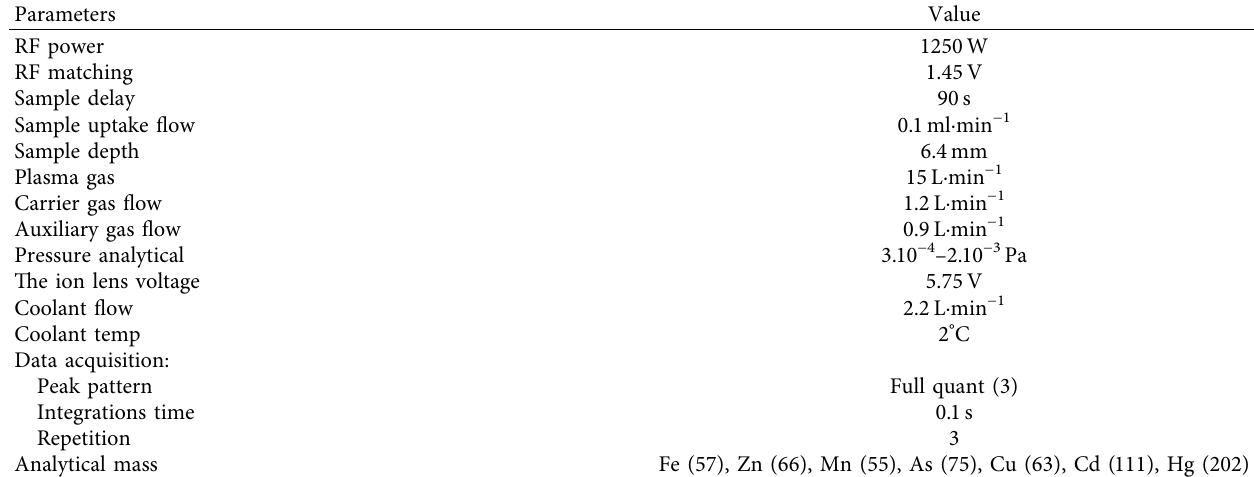
Table 2: Operating parameters of the ICP-MS system.